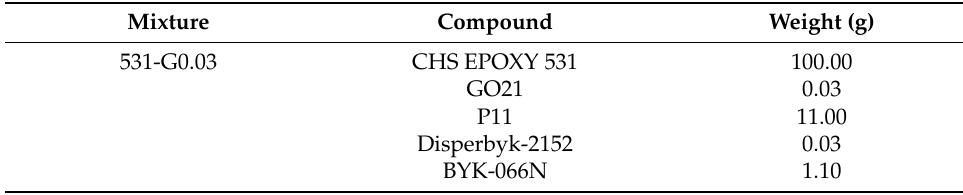
Table A11. Graphene oxide GO21 CHS Epoxy 531, 0.03 phr.